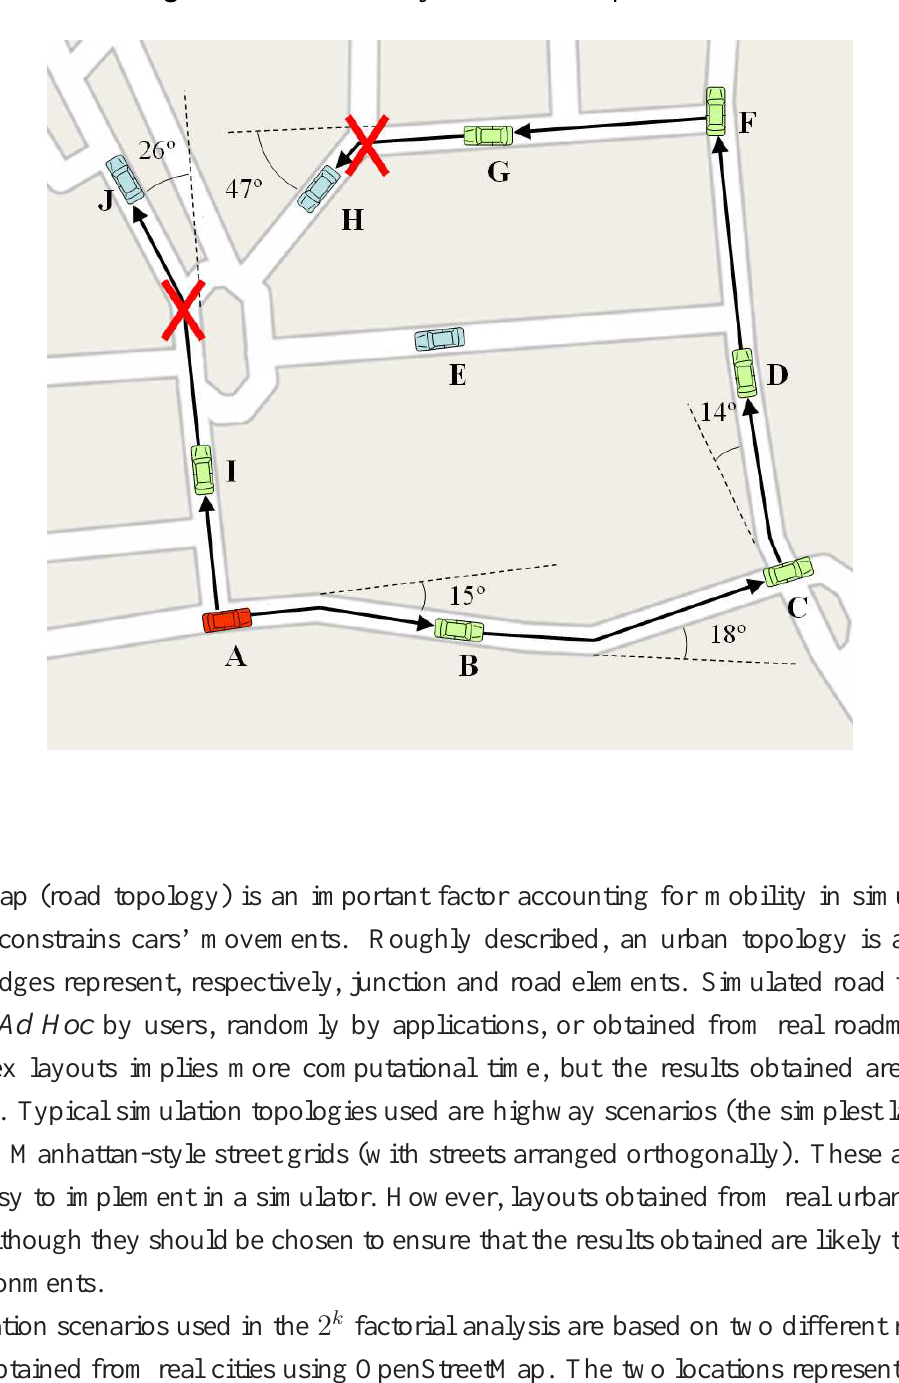
Figure 1. RAV visibility scheme: example